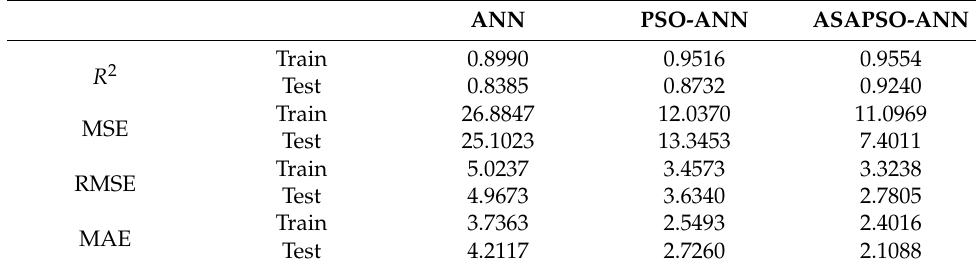
Table 4. Results of the performance evaluation of the three